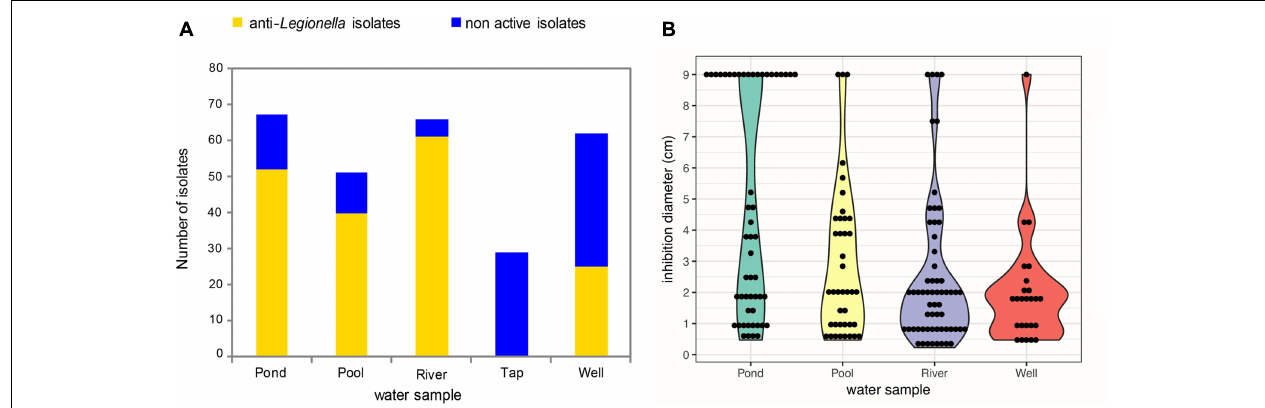
FIGURE 1 | Abundance and distribution of active anti- Legionella bacterial isolates and their inhibition diameters among the five water sub-collections. (A) Active isolates are colored in yellow while non-active isolates are colored in blue. The screening was realized by using spot and lawn assay method. (B) Violin Plot distribution of inhibition diameters among anti- Legionella isolates. Since there is no active isolate within the tap water, the corresponding sub-collection was not represented.